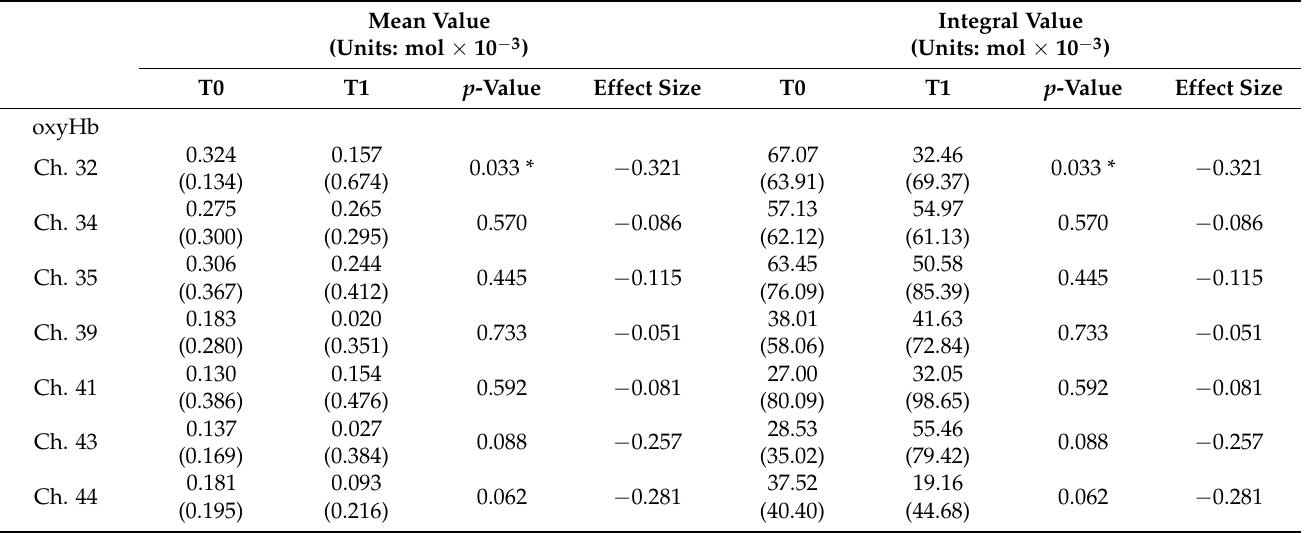
Figure 3. ( A ) Location of the fNIRS channels. The red rhombi represent the individual hMHS locations. The anode electrode was placed on the ipsilesional hemisphere of each participant (C3 or C4). When the anode was on C3, the cathodes were placed on C1, C5, FC3, and CPWhen the anode was on C4, the cathodes were placed on C2, C6, FC4, and CPIn this figure, all patients were assumed to have the right-sided lesions, so the location of the fNIRS channels, optodes, HD-tDCS electrodes, and individual hMHS locations are expressed in the right hemisphere. ( B ) Results of time series oxyHb concentration changes in the affected motor area in each fNIRS channel during the FTT. The red dotted and solid lines represent the oxyHb concentration at T0 and T1, respectively. The blue dotted and solid lines represent the deoxyHb concentration at T0 and T1, respectively. The colored background represents the standard error. In channel 32, the oxyHb concentration was significantly decreased at T1 compared with T0. hMHS, hand motor hotspot; oxyHb, oxyhemoglobin; deoxyHb, deoxyhemoglobin; T0, before intervention; T1, after intervention; FTT, finger tapping task. Table 2. Changes in mean and integral values of oxyHb and deoxyHb in the channels of motor cortical areas in the affected hemisphere during